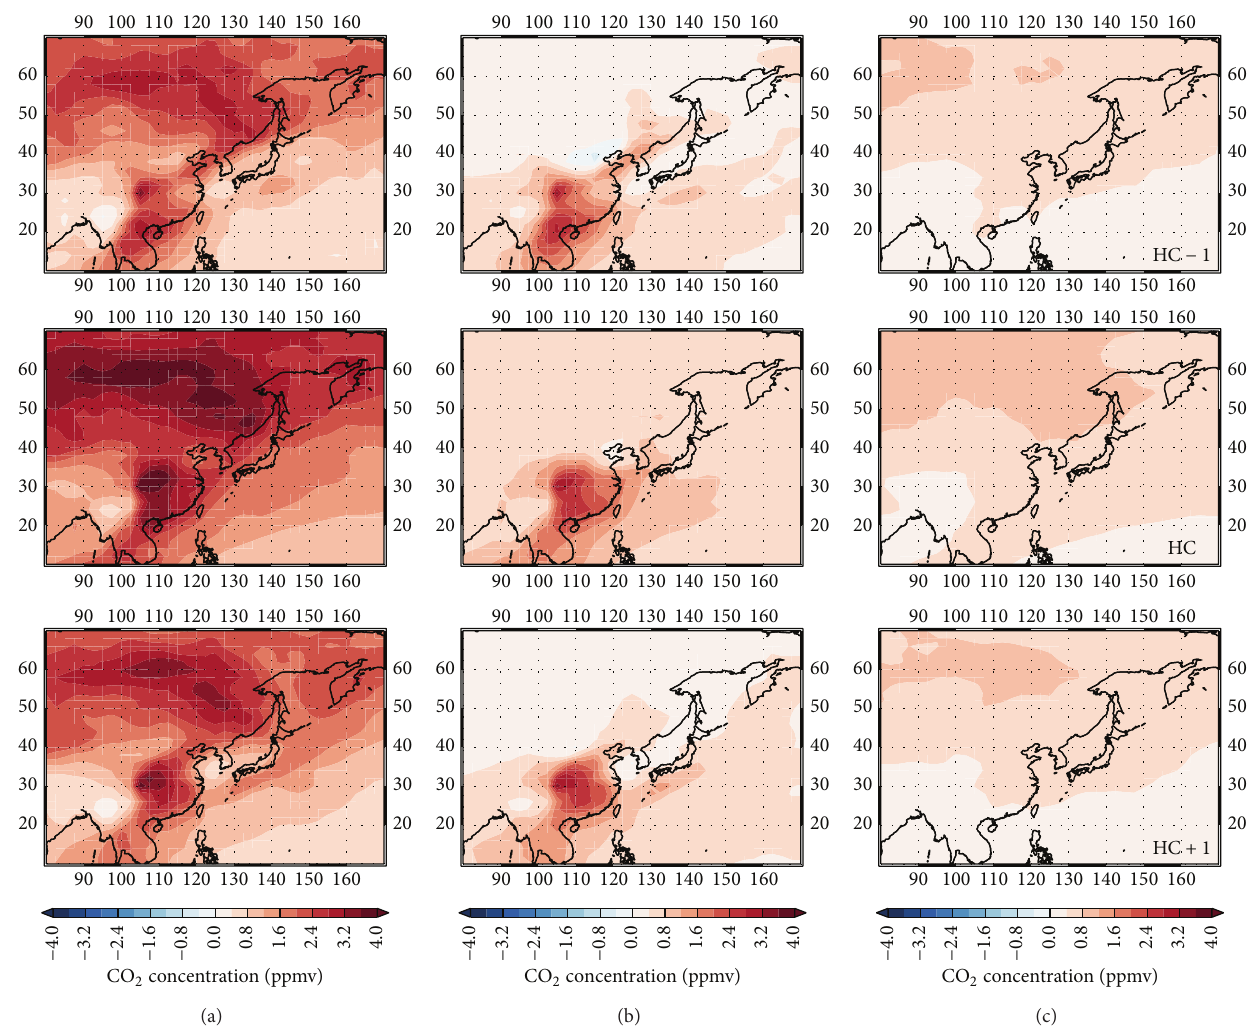
Figure 9: (a) Differences of the column-averaged CO 2 concentrations between high concentration cases (HC − 1, HC, and HC + 1) and all periods (All) simulated by GEOS-Chem. (b) and (c) represent differences of column-averaged CO 2 concentration contributed by emission from East Asia mainland and South and Central Europe by tagged simulation,